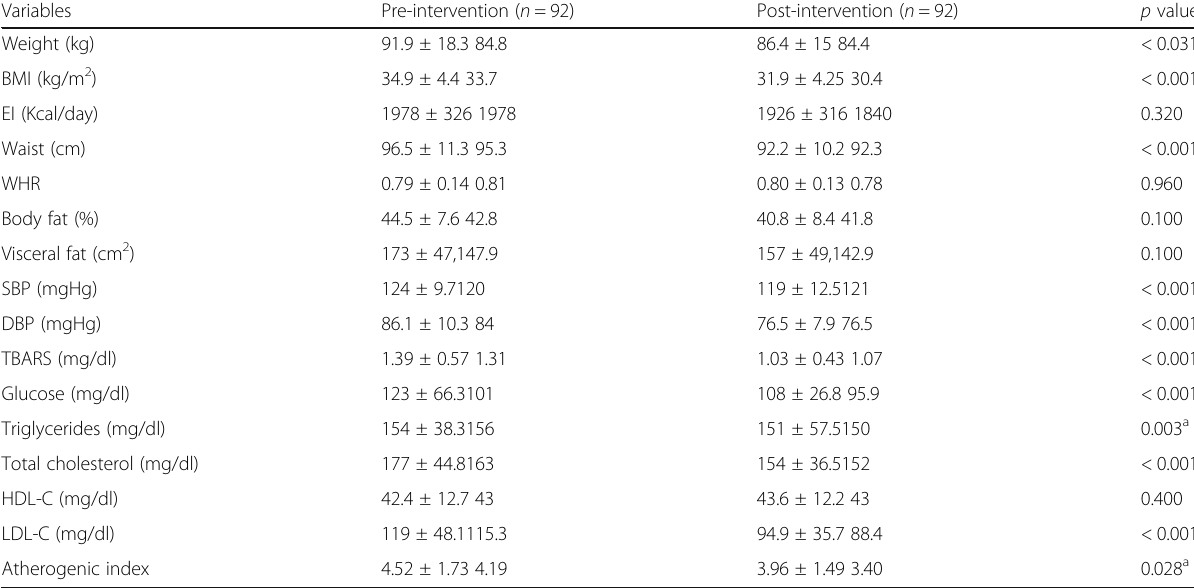
Table 1 Effect of the 3-month dietary intervention on biochemical, clinical, and anthropometric variables on participants